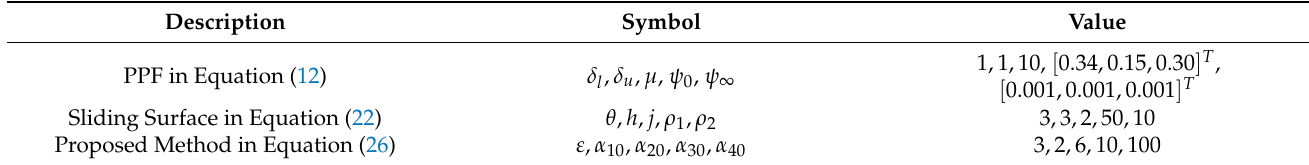
Table 3. The proposed controller